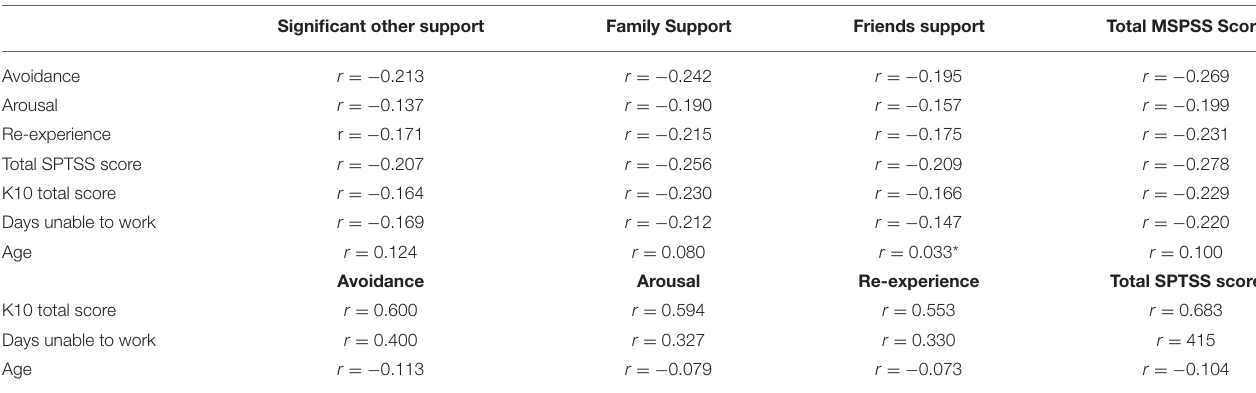
TABLE 6 | Correlations between each cluster of MSPSS, SPTSS, and